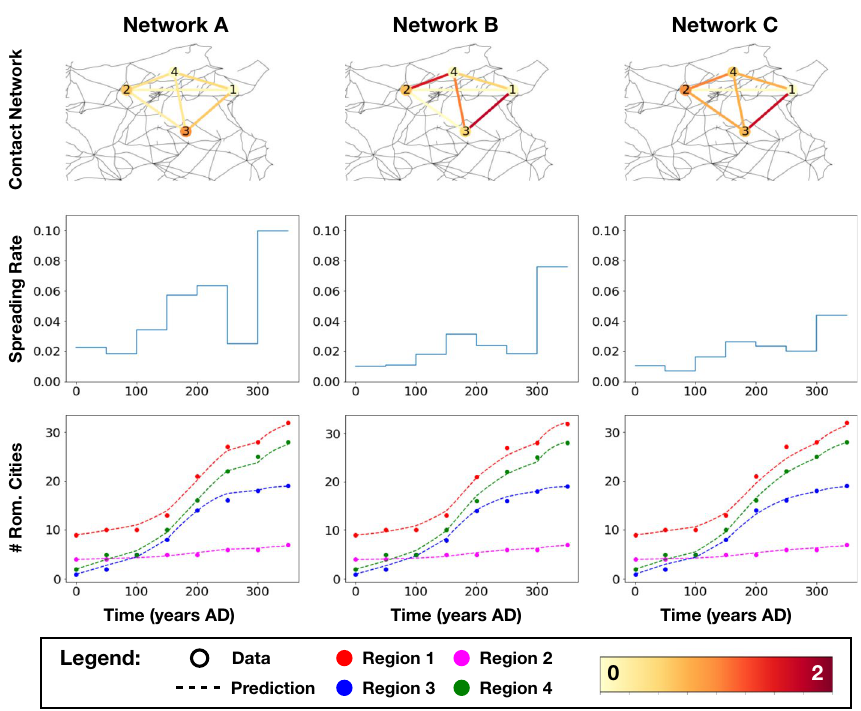
Fig. 3 Representative solutions of the inference problem. Top plot: the contact networks A, B and C. Middle plot: corresponding spreading rate functions. Bottom plot: the resulting spreading curves w.r.t. the available data-points. Network edges are colored according to their weights, s.t. light colors indicate small weights and dark red colors stand for high edge weights. Sources Ancient World Mapping Center (2012); iDAI. geoserver German Archaeological Institute (2022). Licensed under CC BY-NC 3.0. and Open Data